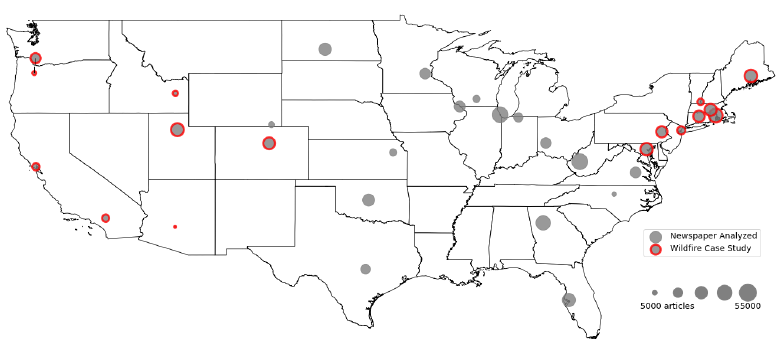
Figure 2. Map of Newspaper Articles. Newspaper sources were constrained by the availability of associated articles through the LexisNexis